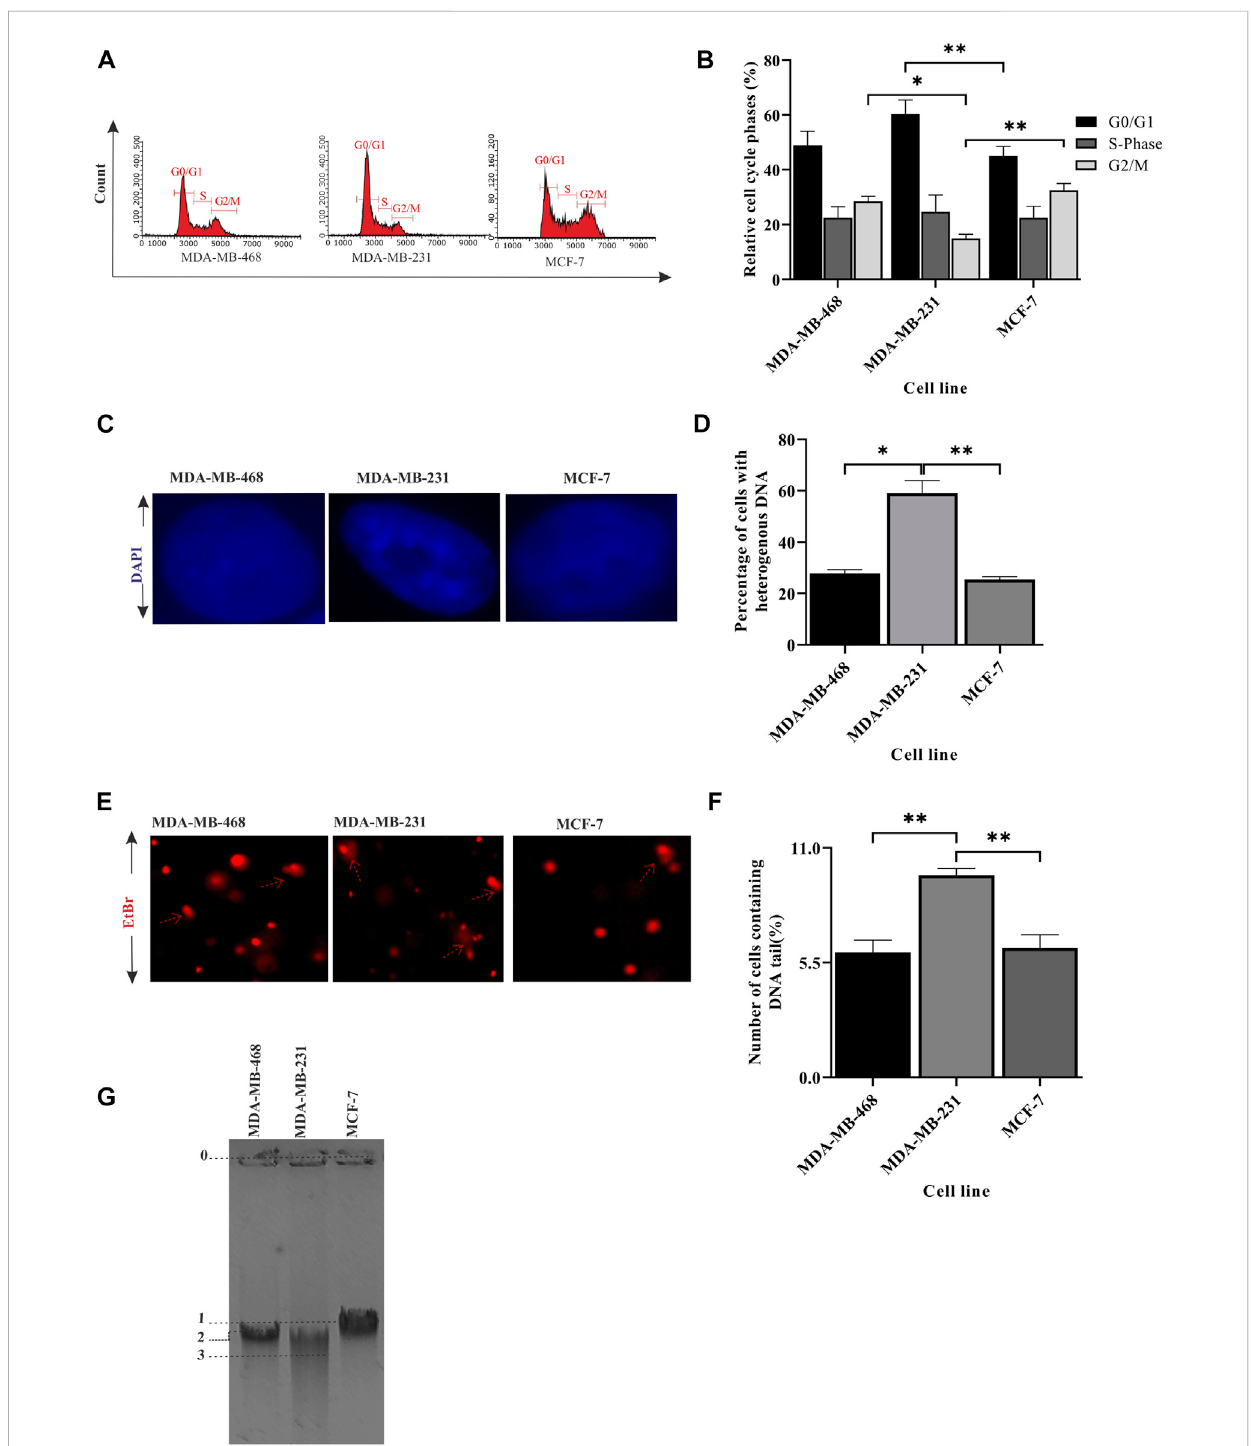
FIGURE 2 Integrity of the genetic material differs between TNBC lines. (A) MDA-MB-231 cells have a signi fi cantly less G2/M population: cell cycle analysis for different breast cancer cell lines, MDA-MB-468, MDA-MB-231, and MCF-7, was performed in a fl ow cytometer. The histogram plot represents the distribution of 5,000 cells into different phases of the cell cycle. (B) Quanti fi cation of the cell population at different stages: the population of cells in differentphasesofthecellcyclewasanalyzedandplottedinabargraphusingInCyte softwareofGuavaeasyCyte. (C) Heterogeneousarrangement ofthegeneticmaterialinMDA-MB-231cells suggestsDNAdamage:representativecell images(×100 magni fi cation) oftheaforementionedlinesstained with DAPI show the homogeneous and heterogeneous arrangement of the genetic material. (D) Quanti fi cation of the increase in heterogeneity in the DNA of MDA-MB-231 cells: the bar graph represents the qualitative analysis of around 200 cells with heterogeneous (blue patches) and homogeneous (evenly spread blue) DNA. (E) Increase in tail formation in MDA-MB-231 con fi rms more DNA damage: representative image of cells having tails of fragmented DNA (comet) shows the extent of DNA damage in different cell types. The cells with the elongated tails are marked with broken red line